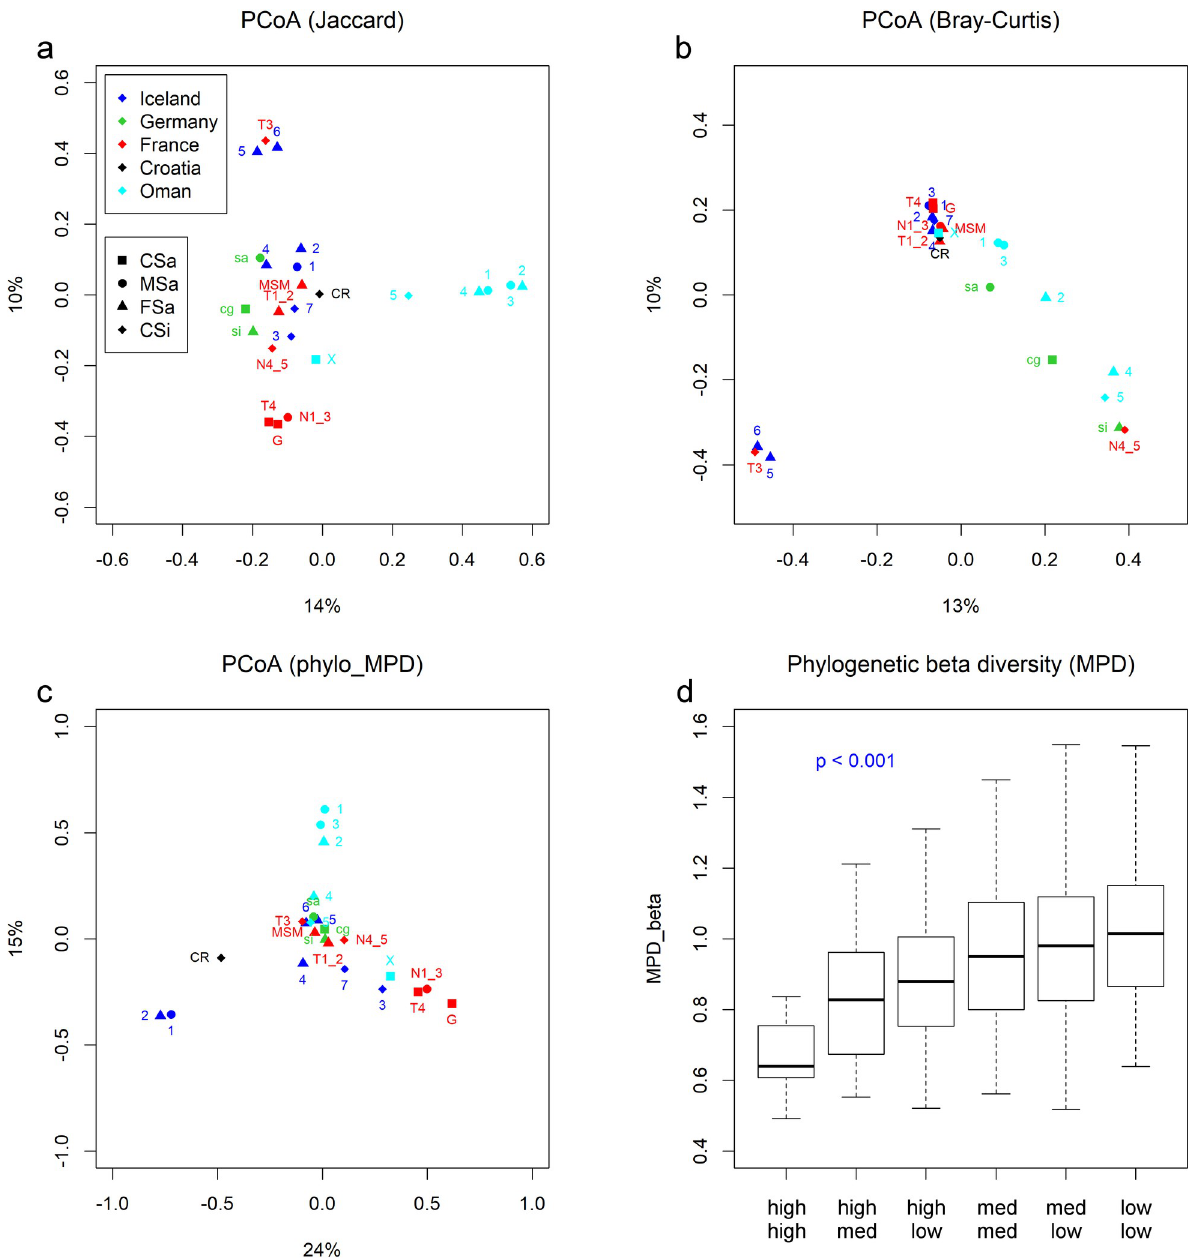
Fig 6. Dissimilarity patterns revealed by PCoAs (a-c) and phylogenetic beta diversity (MPD) between paired samples according to their stabilization level (d) . PCoAs were based on Jaccard (a) and Bray-Curtis (b) dissimilarity coefficients and the phylogenetic distance matrix (c) of all representative sequences per OTU (abundance unweighted); the first two axes explain a total variability of 24%, 23% and 39%, in a, b, and c respectively. (d) Kruskal-Wallis tests were performed to identify significant differences of phylogenetic beta diversity estimates (MPD) between samples that were grouped according to their stabilization